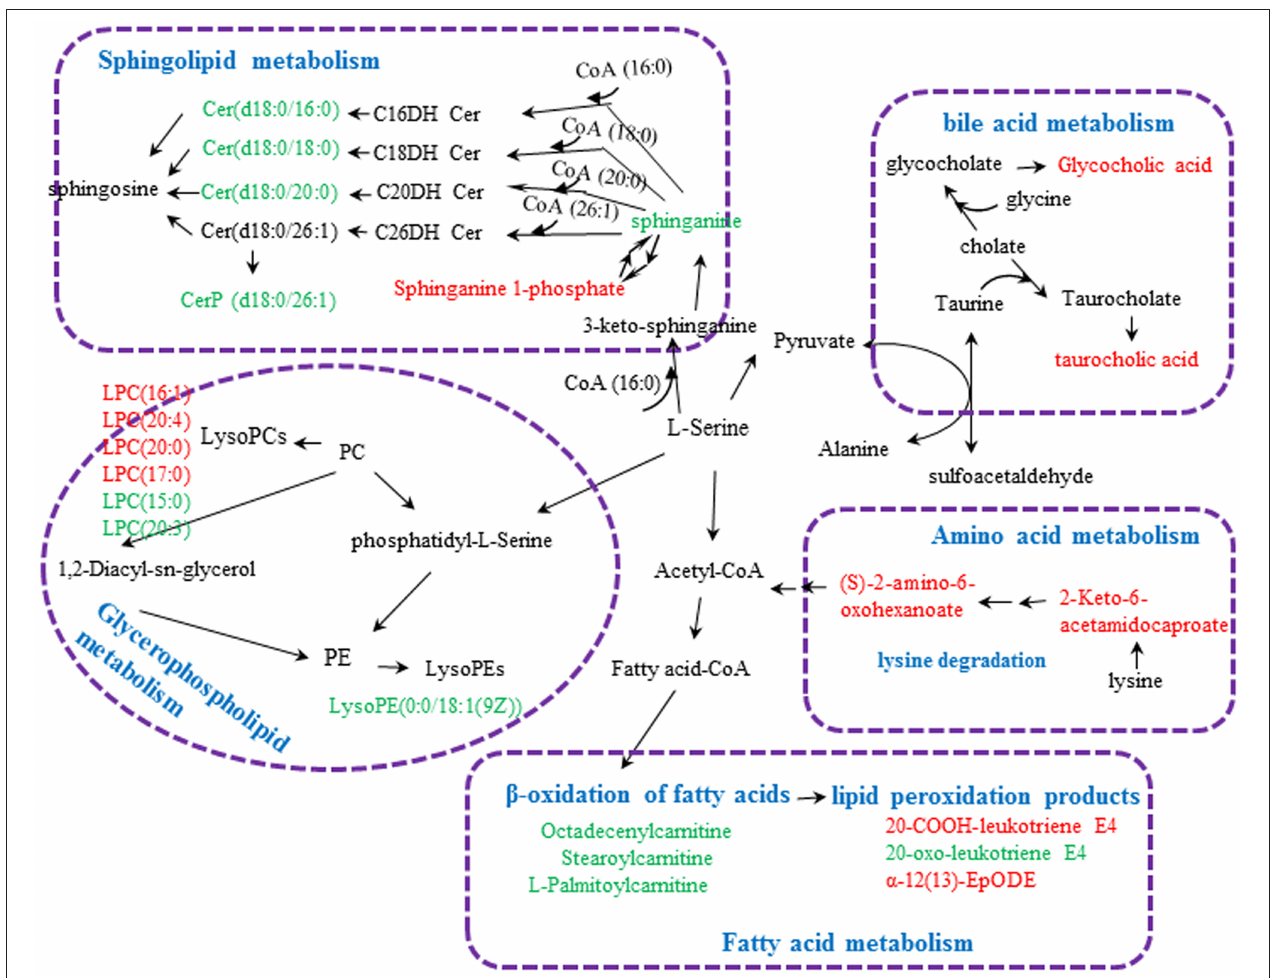
FIGURE 8 | Metabolic pathways involved in the [Z4], [Z6], or [Z7] group vs. the [K] group. Red fonts represent up-regulated metabolites in the [Z4], [Z6], or [Z7] group vs. the [K] group; Green fonts represent down-regulated metabolites in the [Z4], [Z6], or [Z7] group vs. the [K] group. Blue fonts represent the metabolic pathway.